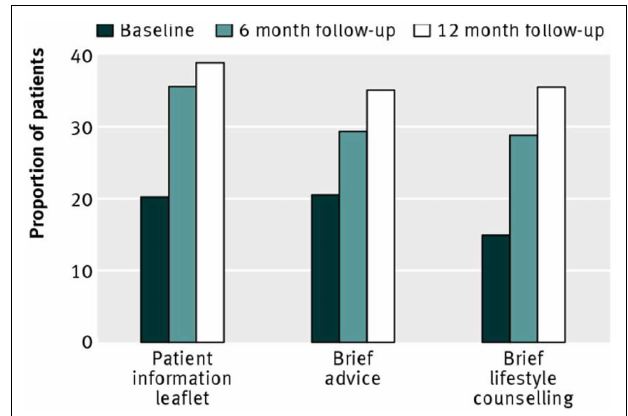
FIGURE 2 | Proportion of patients scoring < 8 (negative status) on the alcohol use disorders identification test, representing non-hazardous or non-harmful drinking . Reproduced from Kaner et al. [(19), p.